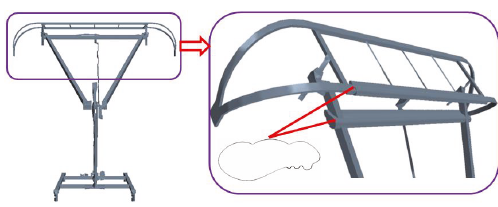
Figure 12: Improved geometric model of pantograph.